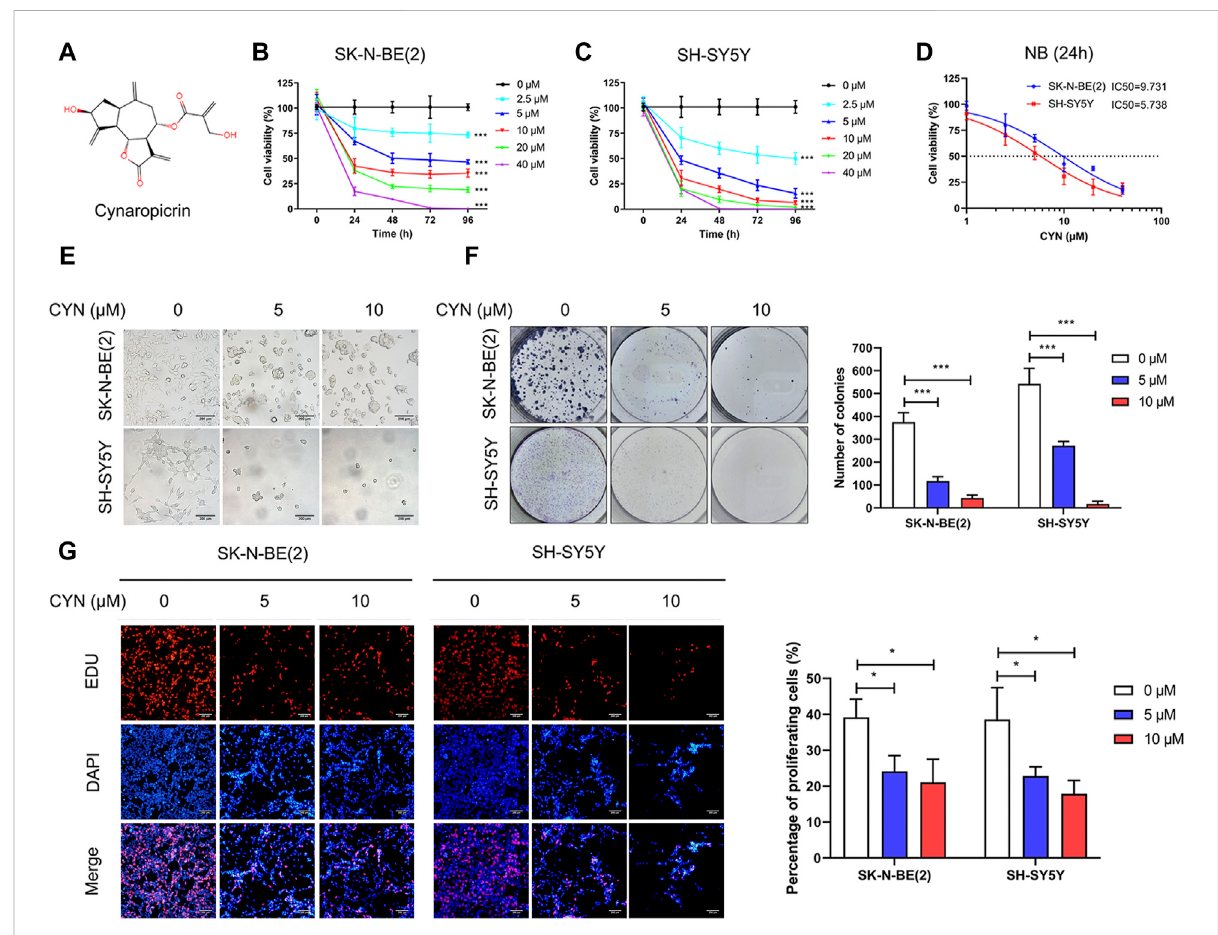
FIGURE 1 Effects of CYN on cell viability in NB cells. (A) The structure of cynaropicrin. (B , C) Cell viability was evaluated by CCK-8 assay. (D) IC50 was analyzed via the cell viability assay. (E) Morphological changes of NB cells (Scale bar = 200 µm). (F) Colony formation assay of NB cells treated with CYN. (G) EDU incorporation assay of NB cells treated with CYN (Scale bar = 200 µm). * p < 0.05, *** p < 0.001 versus the control